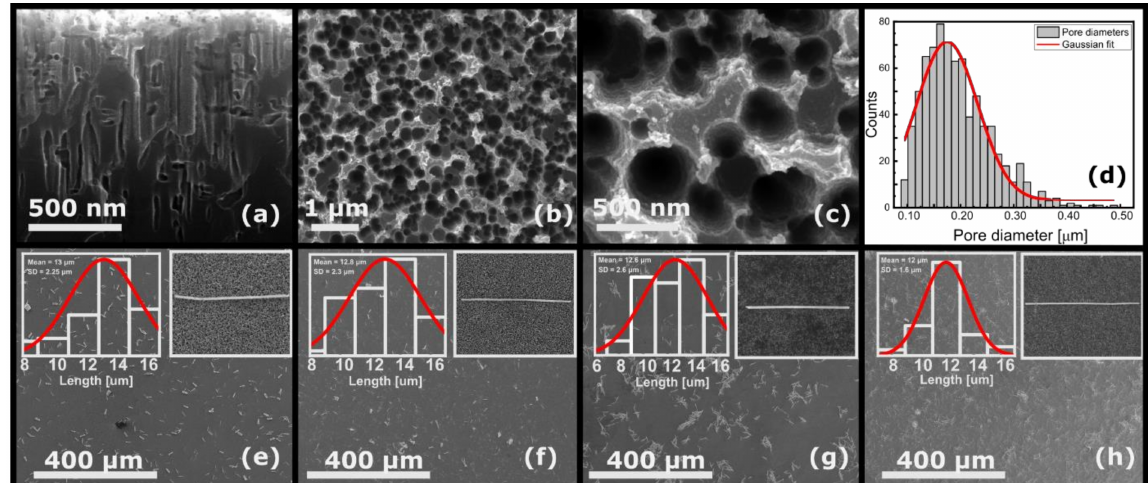
Figure 1. ( a ) Side-view and ( b ) top-view SEM images of the vertical etched Si layer. ( c ) Different-sized Si nanoholes arrayed inside the silicon windows. ( d ) Statistics of Si nanoholes’ morphology, and four different types of NWs deposited on the SiNHs’ surface (inset: SEM image of a single nanowire and nanowires length distribution): ( e ) AgNWs, ( f ) AuNWs, ( g ) NiNWs and ( h ) PtNWs,